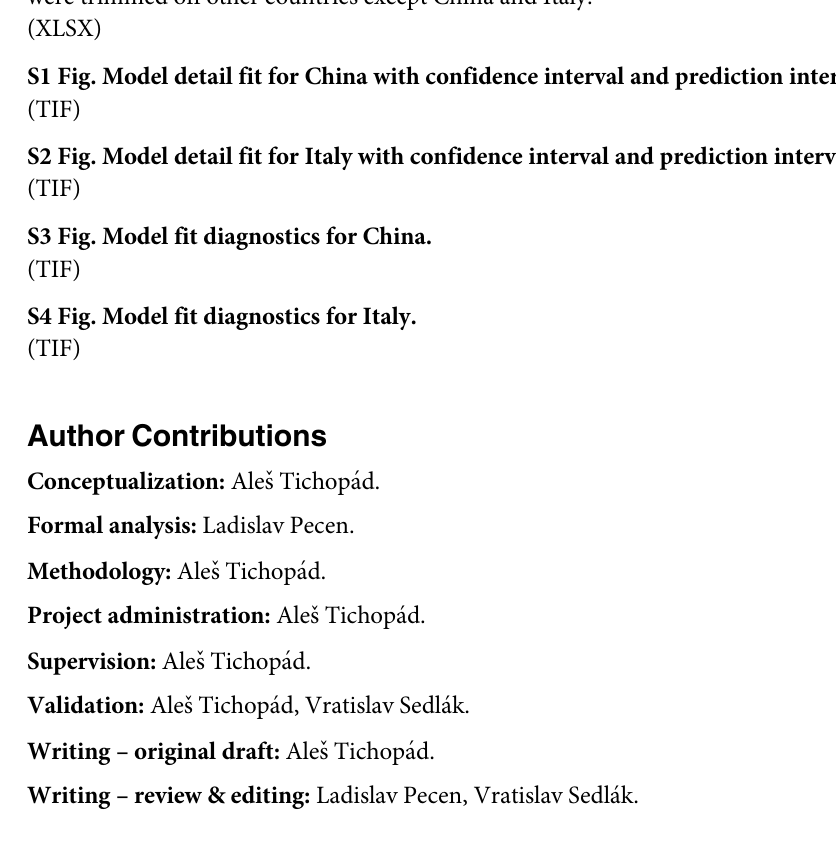
S1 Fig. Model detail fit for China with confidence interval and prediction interval. S2 Fig. Model detail fit for Italy with confidence interval and prediction interval. S3 Fig. Model fit diagnostics for China. S4 Fig. Model fit diagnostics for